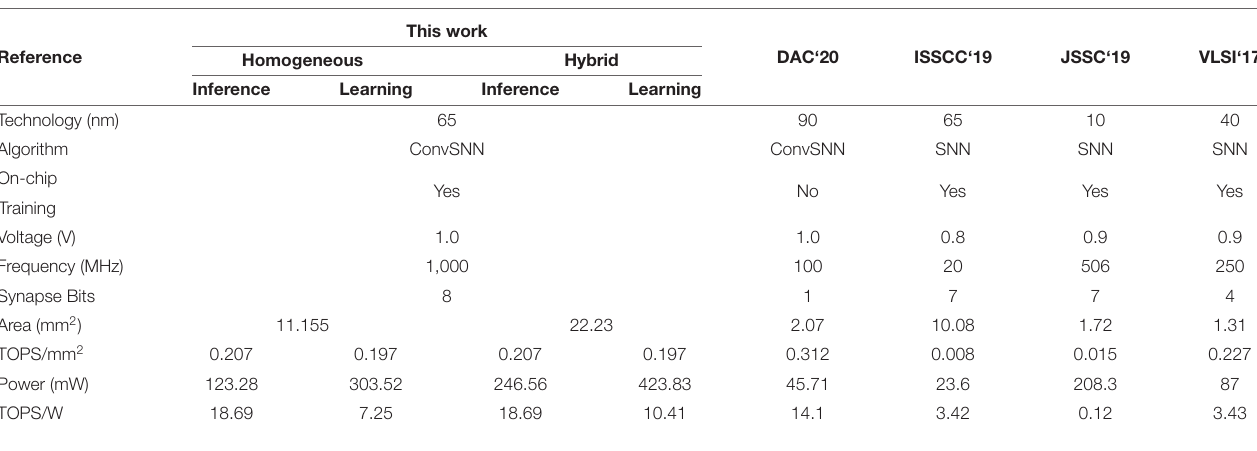
TABLE 3 | Comparison with other